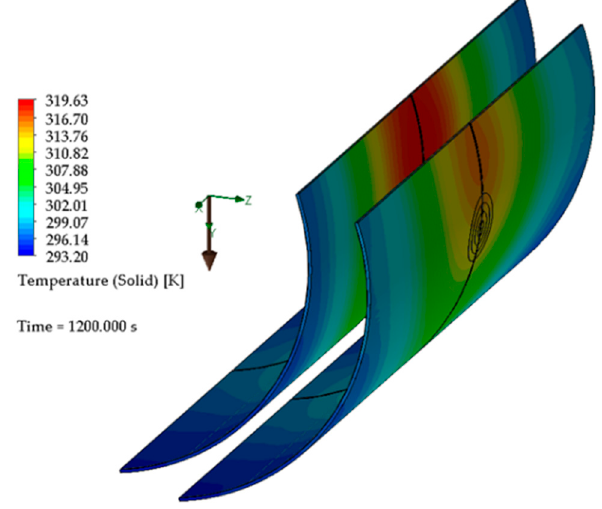
Figure 25. Temperature at 1200 s.